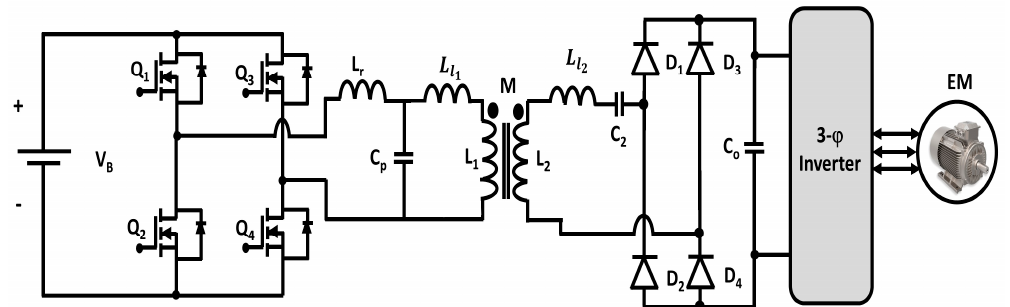
Figure 20. Inductive WPT system with LCL compensation topology.